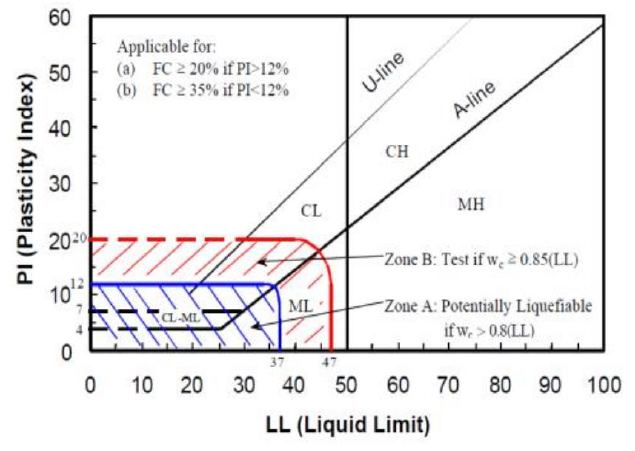
Figure 2: Seed et al. modified liquefaction potential criterion based on modified Chinese criterion developed by